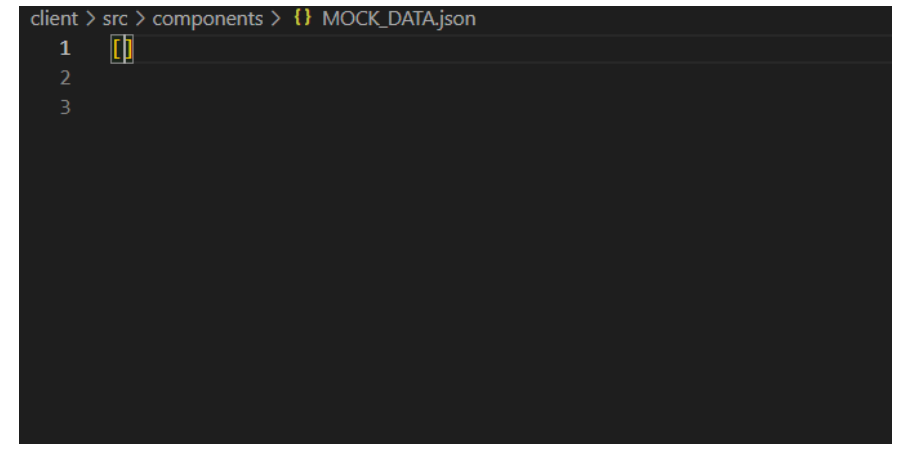
Figure 22. Text file with no data.